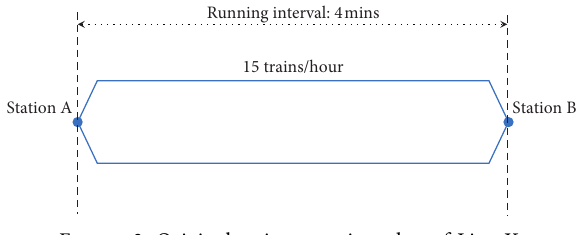
Figure 3: Original train operation plan of Line X.